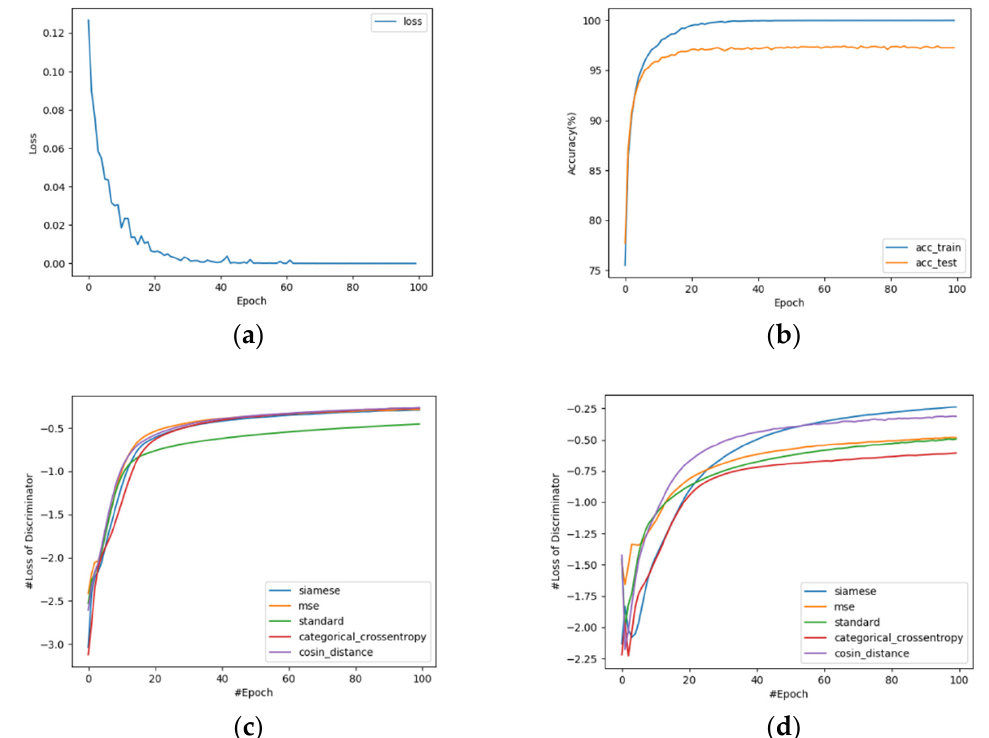
Figure 5. Training Siamese Network on MNIST dataset. ( a ) The trend of loss as epoch increases. ( b ) The trend of accuracy on training set and test set as epoch increases. ( c ) Trend of discriminator’s loss trained with different conditional losses on MNIST. ( d ) Trend of discriminator’s loss trained with different conditional losses on Fashion-MNIST.